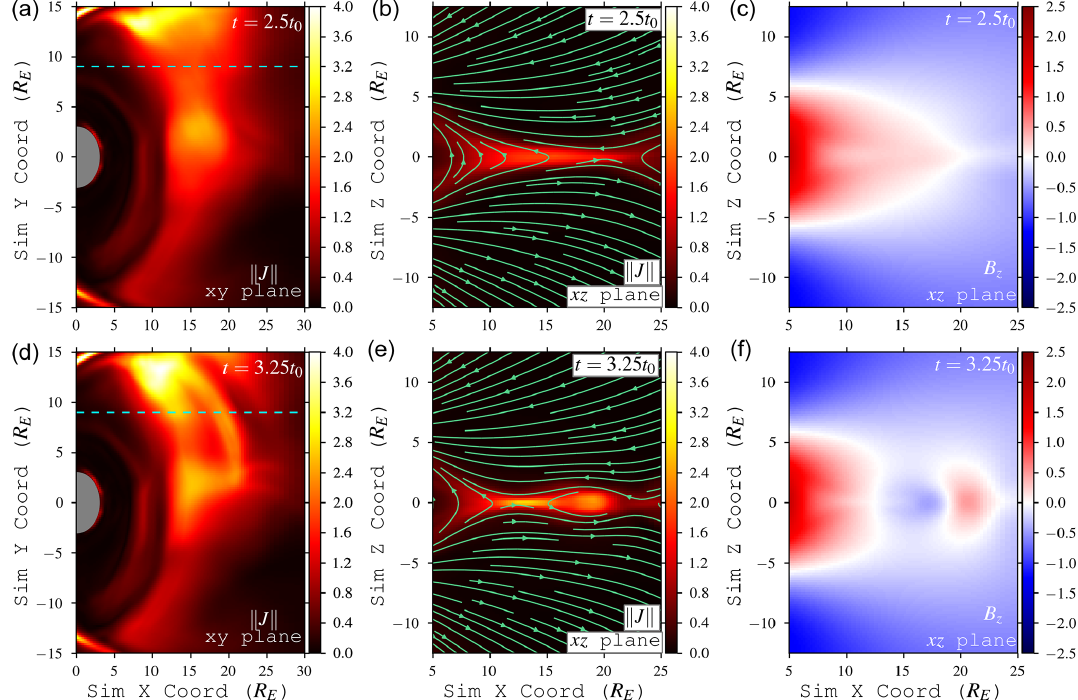
Figure 6. Formation and evolution of a global dipolarization due to locally reconnecting magnetic field lines in the xy and xz planes, as seen in the evolution of magnetotail current density ( (cid:107) J (cid:107) ) and normal magnetic field B z . (cid:107) J (cid:107) is normalized via J 0 = B w /L 0 ; B z is normalized via B w = 10 − 4 G. Displayed times are relative to the sequence shown in Fig. 5. The dashed cyan lines in (a) and (d) mark the y position of the xz cuts in (b) , (c) , (e) , and (f)